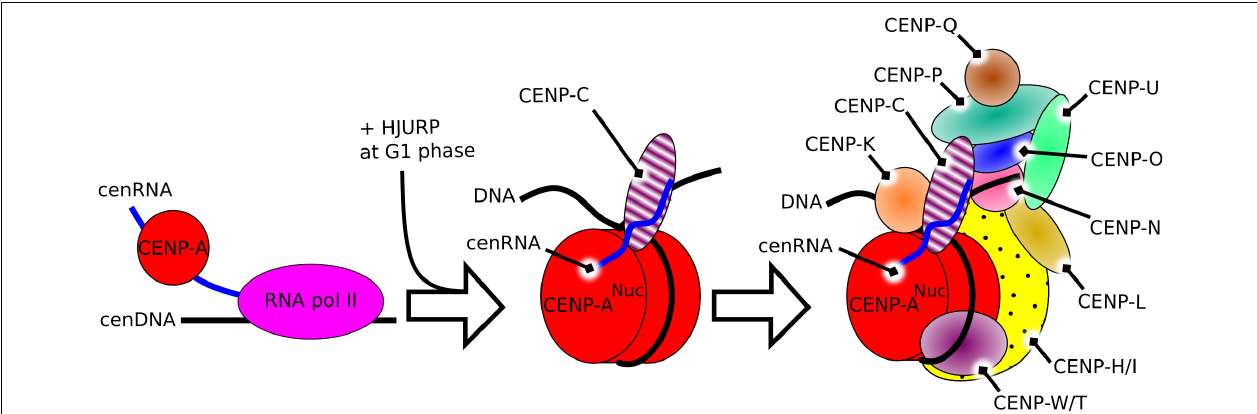
FIGURE 1 | Schematic representation of the constitutive role of cenRNA in the structure of the centromere in humans. Left , the product of transcription of alpha-satellite DNA by the RNA polymerase II recruits CENP-A. Middle , after the constitution of the CENP-A nucleosome, cenRNA recruits CENP-C. Right , during mitosis, cenRNA may still be associated with the CCAN, and recruit the CPC via interaction with Aurora B to build the whole kinetochore.